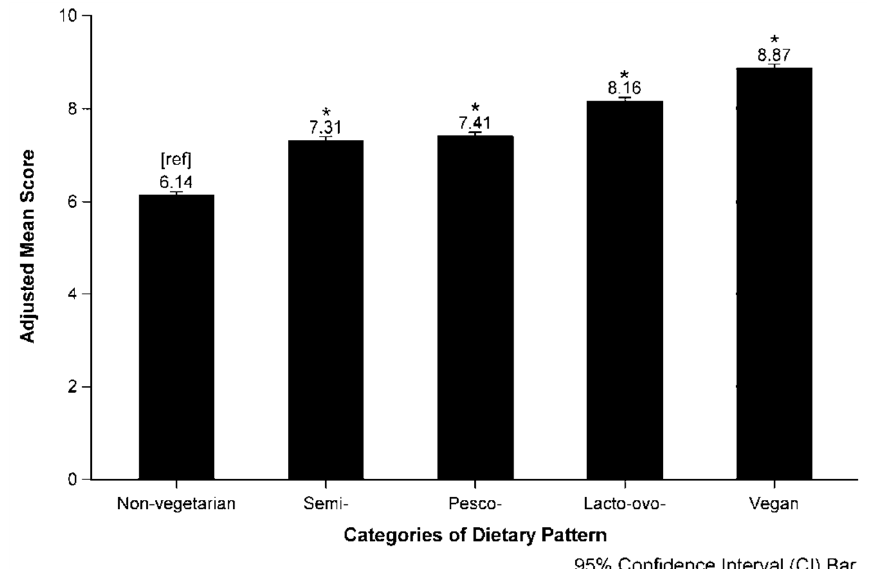
Model 1: Unadjusted model. Model 2: Adjusted for gender, age, race/ethnicity, and family history of cancer. Model 3: Adjusted as in Model 2 + BMI, smoking status, and alcohol use. Model 4: Adjusted as in Model 3 + marital status, household income, and educational level. Marginal (adjusted) means were reported for analysis of covariance (ANCOVA) models 2, 3, and 4. A global p -trend test with p < 0.05 indicates statistical significance. Model 1, 2, 3, and 4 ( p -trend < 0.0001)